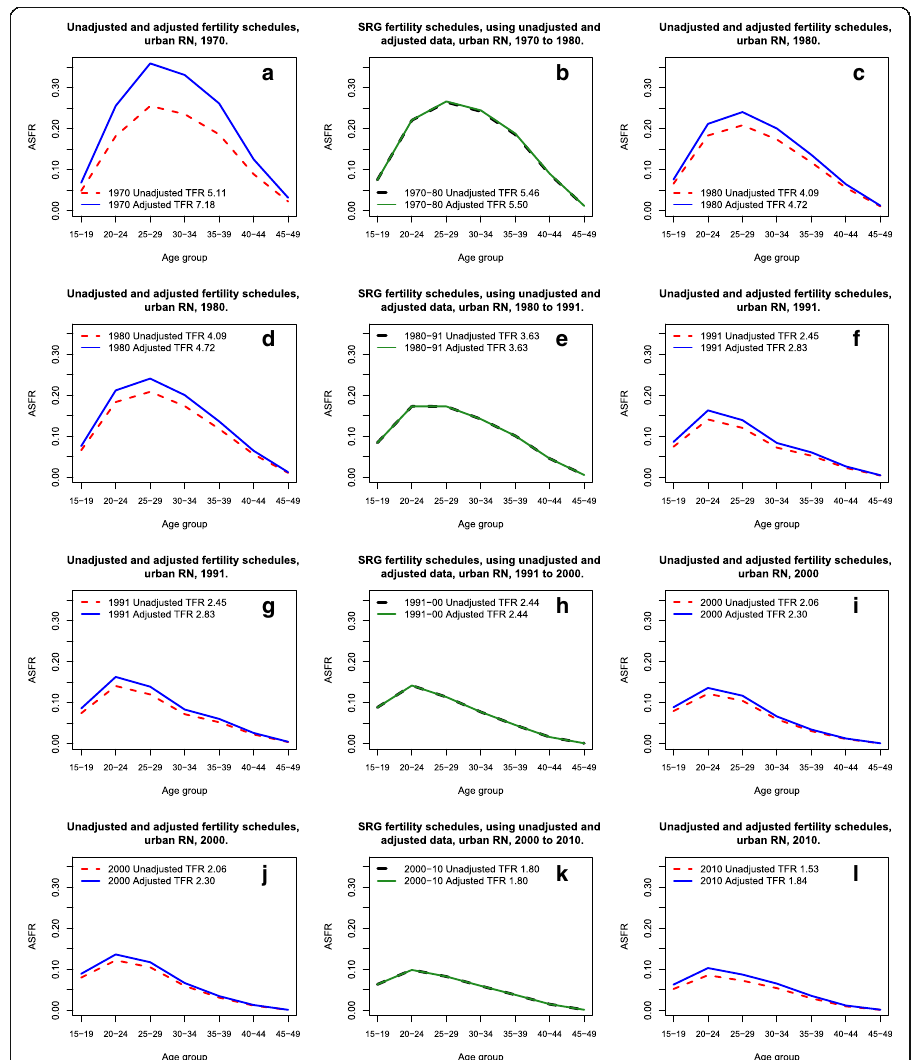
Fig. 1 Fertility schedules estimated by traditional Brass method and by SRG model, urban Rio Grande